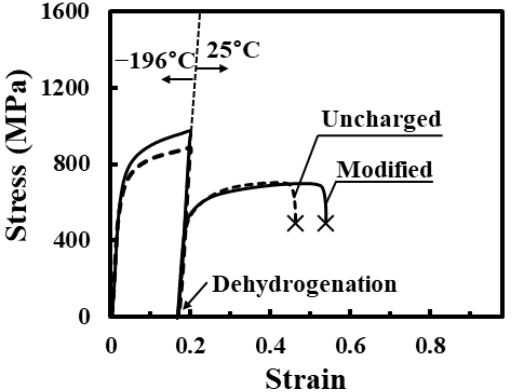
Figure 13. Tensile stress–strain curves at 25 °C for uncharged specimen and specimen subjected to modified charging and dehydrogenation at 200 °C for 24 h after the tensile straining to 0.2 at −196 °C.